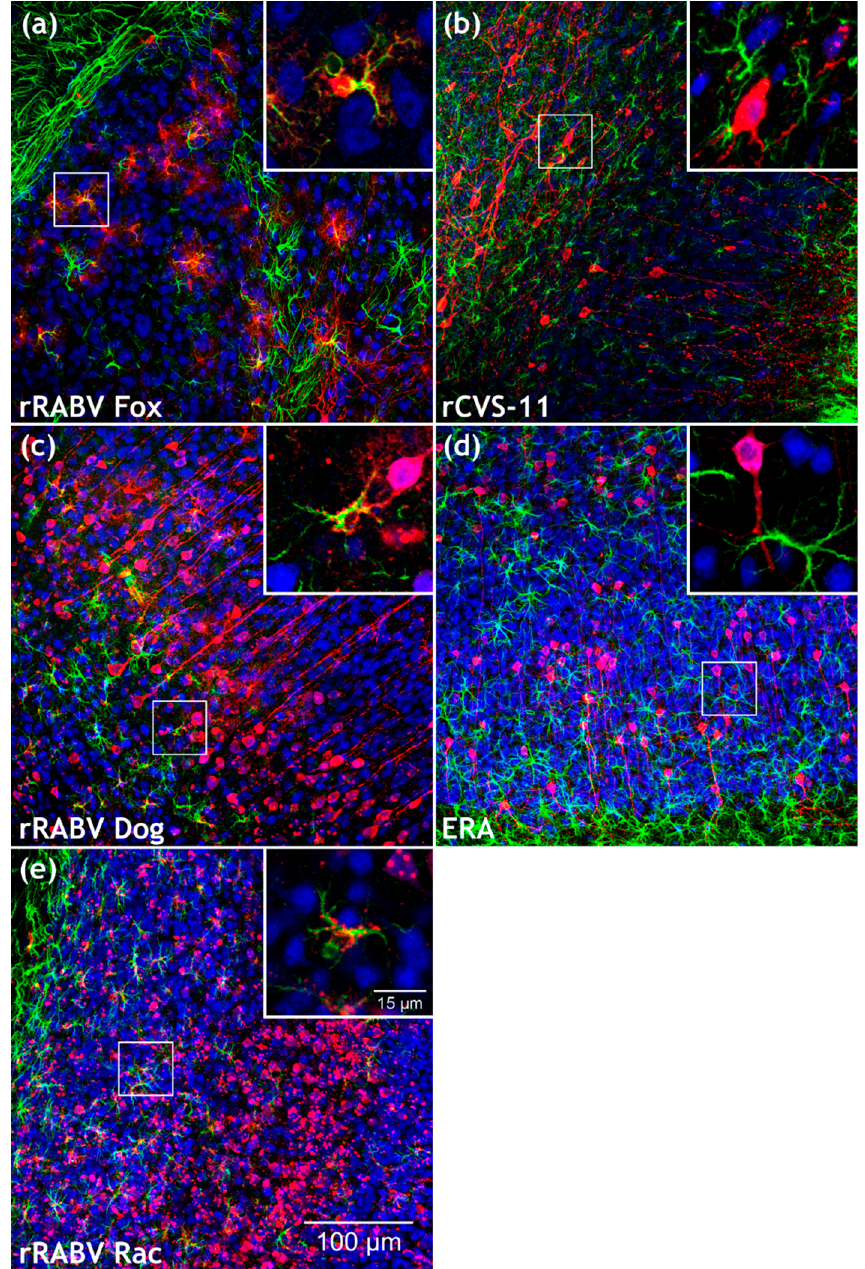
Figure 4. Comparison of field and lab RABV-infected brains after intramuscular (i.m.) infection with rRABV Fox, rRABV Dog, rRABV Rac, rCVS-11, and Evelyn Rokitnicki Abelseth (ERA). ( a–e ) Maximum z-projections of z-stacks [x, y = 400 µm, 400 µm ( a–e ); z = 59 µm ( a , rRABV Fox), 66 µm ( b , rCVS-11), 49 µm ( c , rRABV Dog), 100 µm ( d , ERA) and 89 µm ( e , rRABV Rac)] after indirect immunofluorescence for RABV phosphoprotein P (red), GFAP (green), and NeuN (blue). To improve visualization of the maximum z-projections, some z-stacks were reduced in thickness. For the full z- stacks, refer to Supplementary Video S4. Insets in Figure 4a,c,e show RABV P accumulation (red) at GFAP-positive cells (green). Insets in Figure 4b,d show NeuN- (blue) and RABV P (red)-positive neurons. For the individual channels of the detail images, see Supplementary Figure S4.